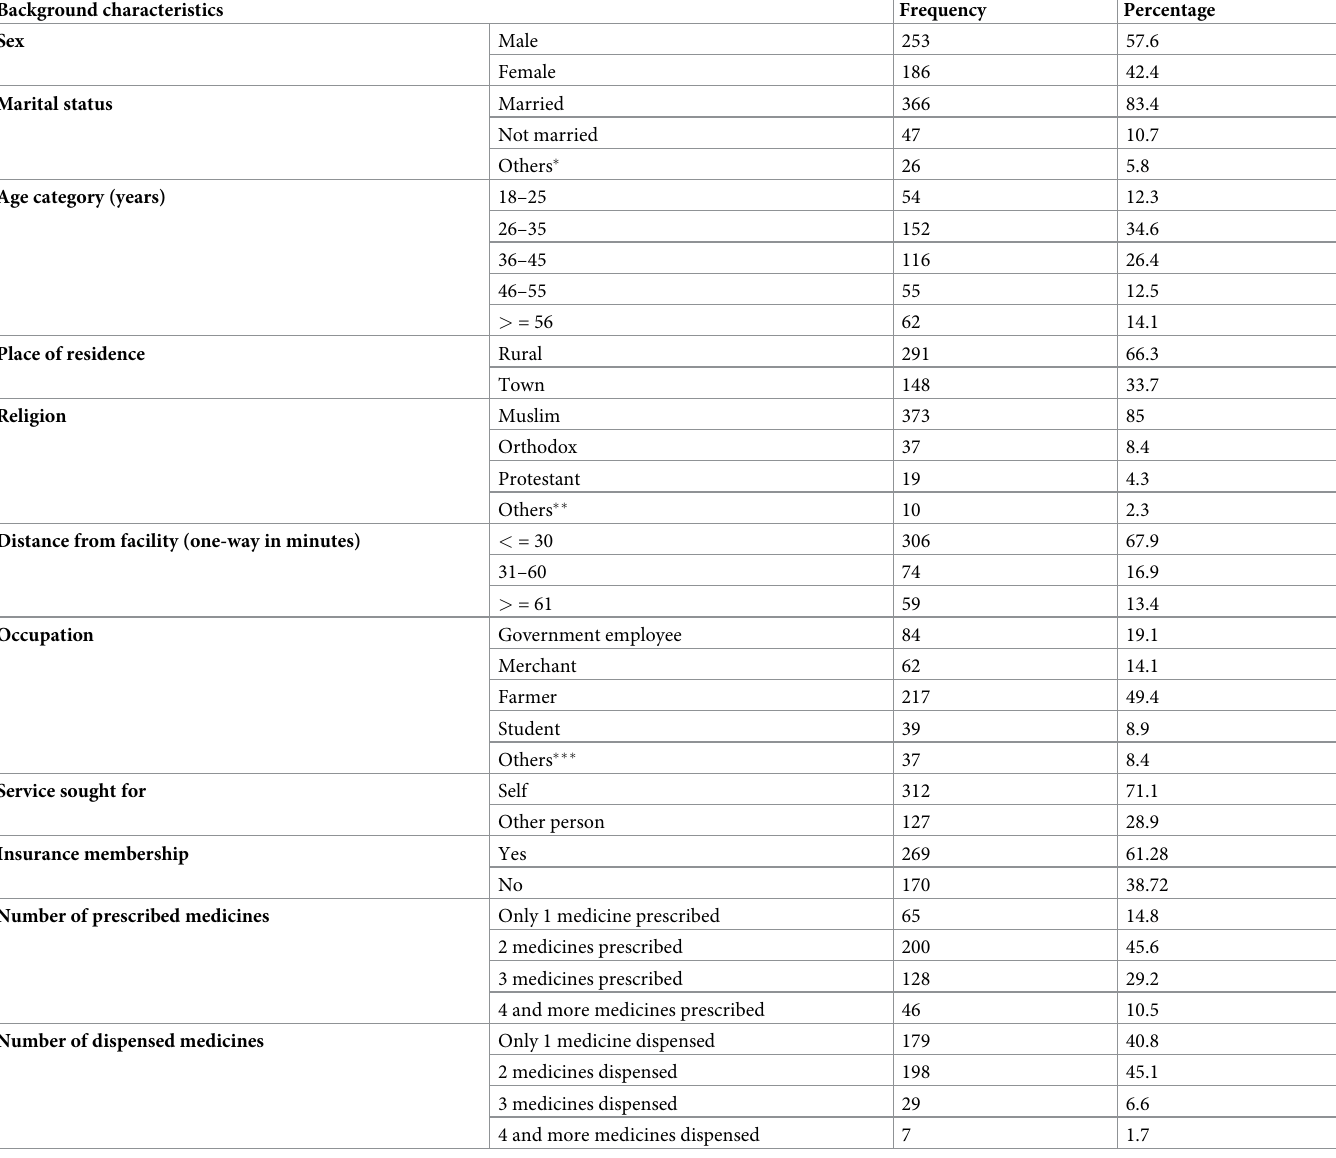
Table 1. Background characteristics of the respondents, and pharmaceuticals. December 2020 (n = 439). Background